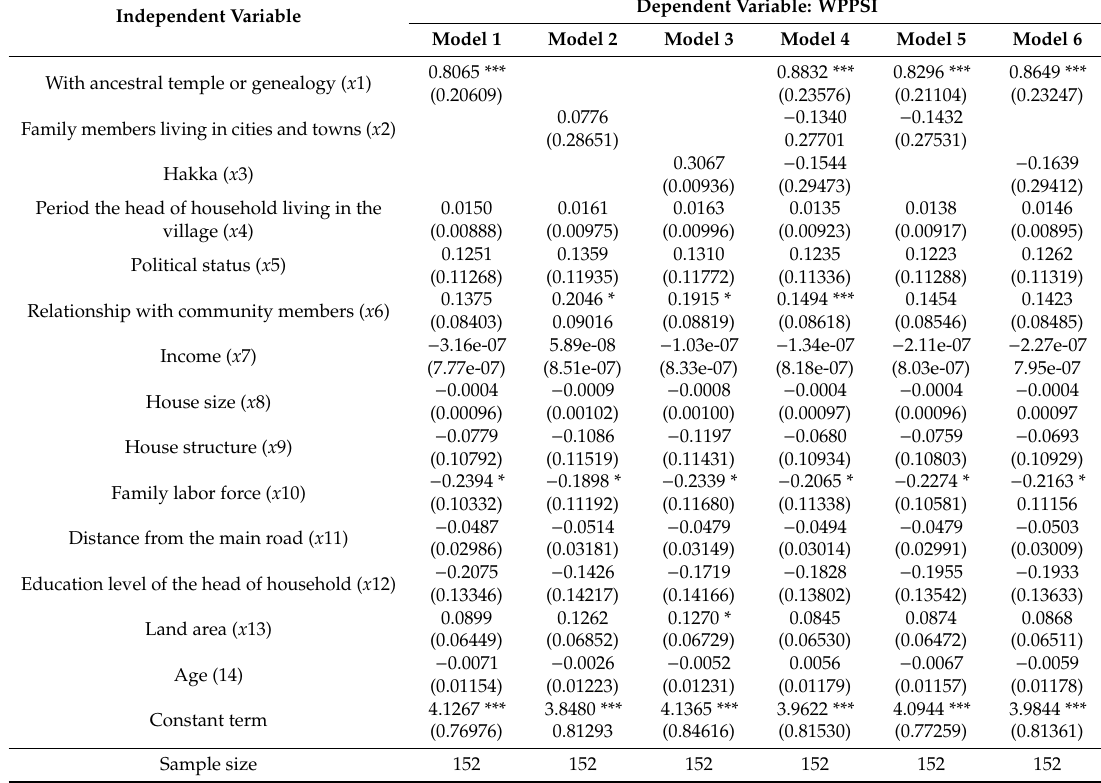
Table 4. Regression results of Tobit model of limited dependent